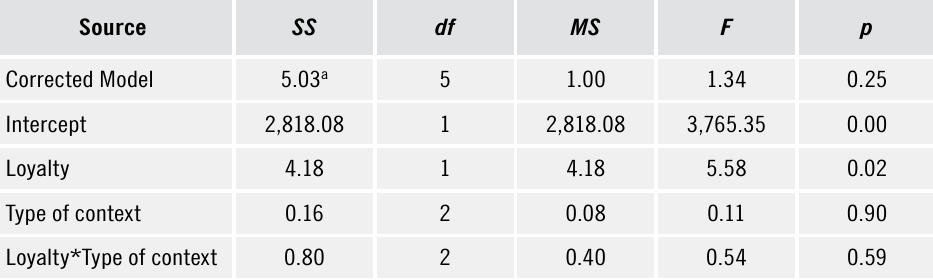
Table 4. Results of 2x3 ANOVA